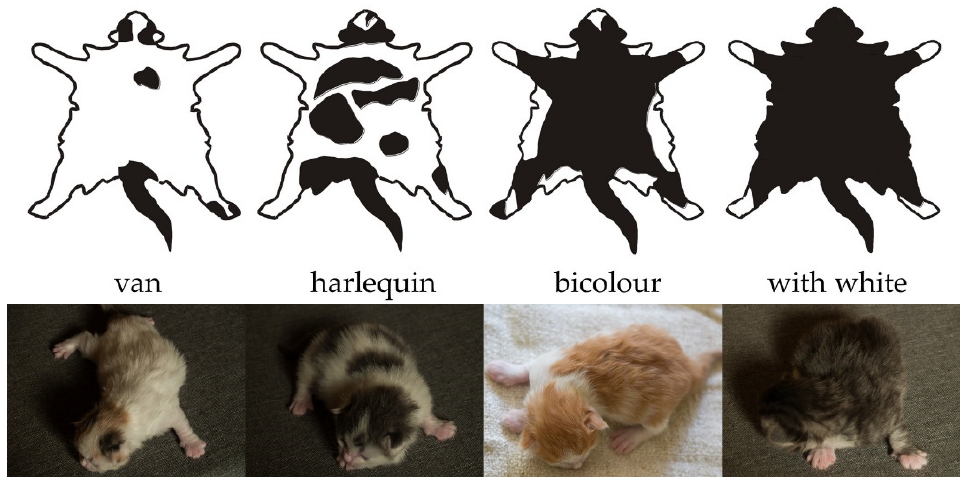
Figure 1. Examples of the distribution of white spotting in van (EMS code 01), harlequin (02), bicolor (03) and unspecified amount of white (09) according to Fédération Internationale Féline d’Europe